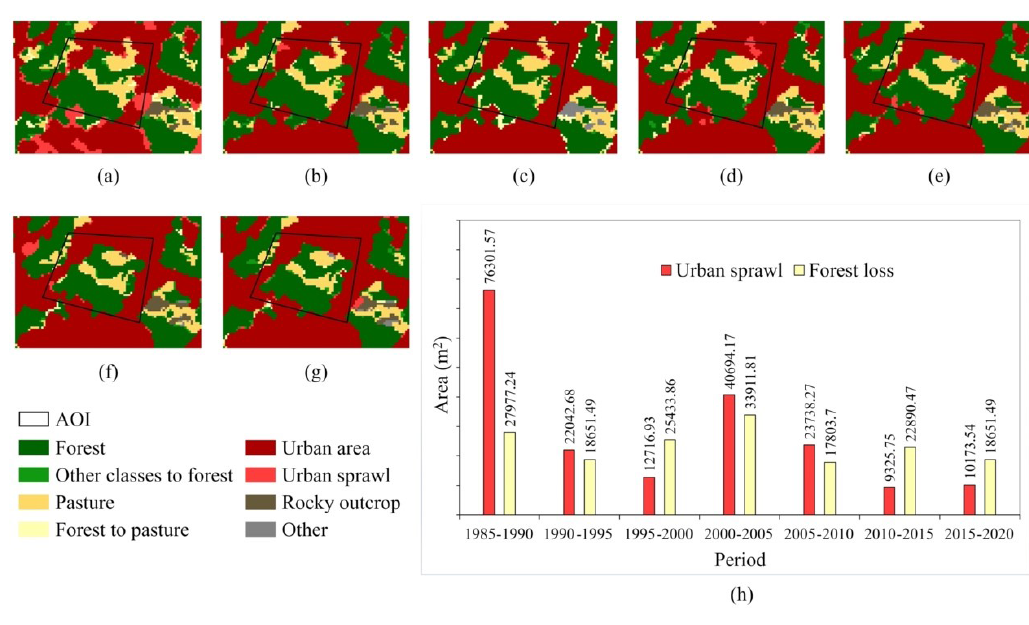
Figure 10. Transition classes for the study area: (a) 1985–1990, (b) 1990–1995, (c) 1995–2000, (d) 2000–2005, (e) 2005–2010, (f) 2010– 2015, (g) 2015–2020, and (h) area (m 2 ) of urban sprawl and forest loss over the analyzed period.